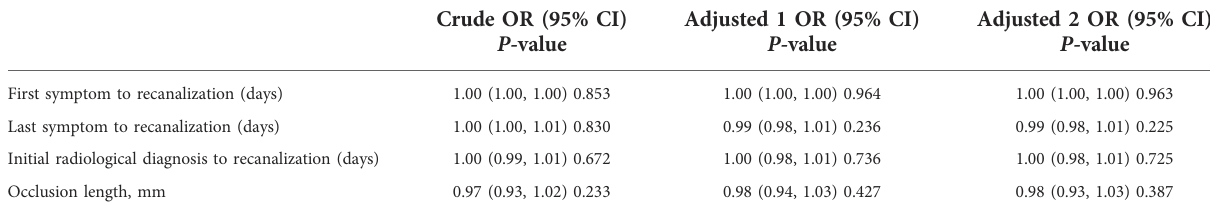
TABLE 3 Univariate analysis of successful recanalization.